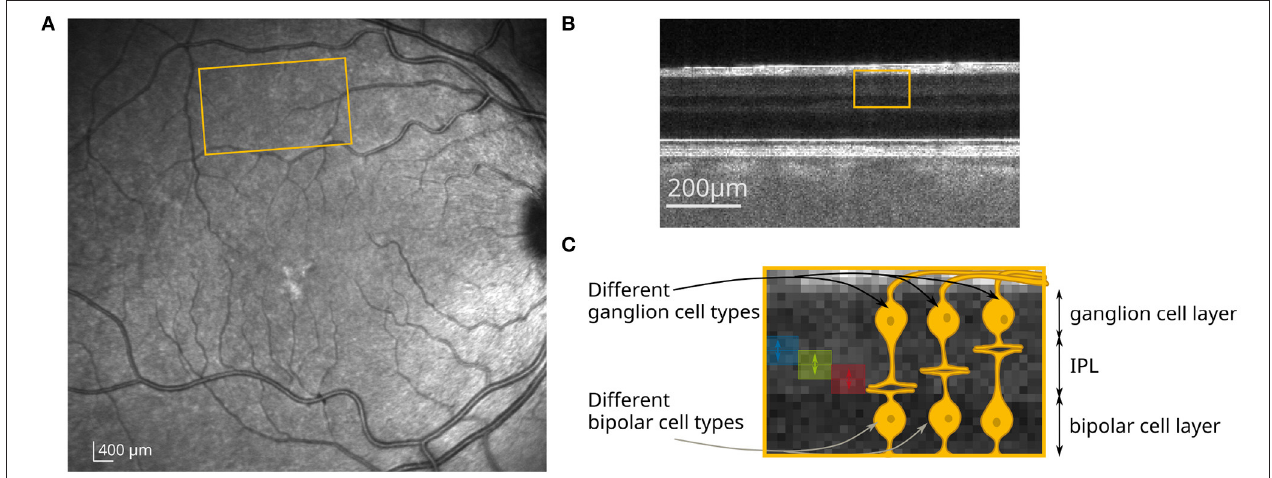
FIGURE 1 | (A) Scanning laser ophthalmoscope (SLO) image at 815 nm (Spectralis, Heidelberg Engineering); yellow marked region corresponds to the field of view at 10 ◦ superior to the fovea. (B) B-scan of the retina imaged with an FF-SS-OCT system at this position. (C) Yellow marked region from (B) and close-up with a schematic drawing of the neuronal connections in the IPL. The different sub-layers of the IPL, for which the optical path length changes were obtained, are marked by the blue, green, and red